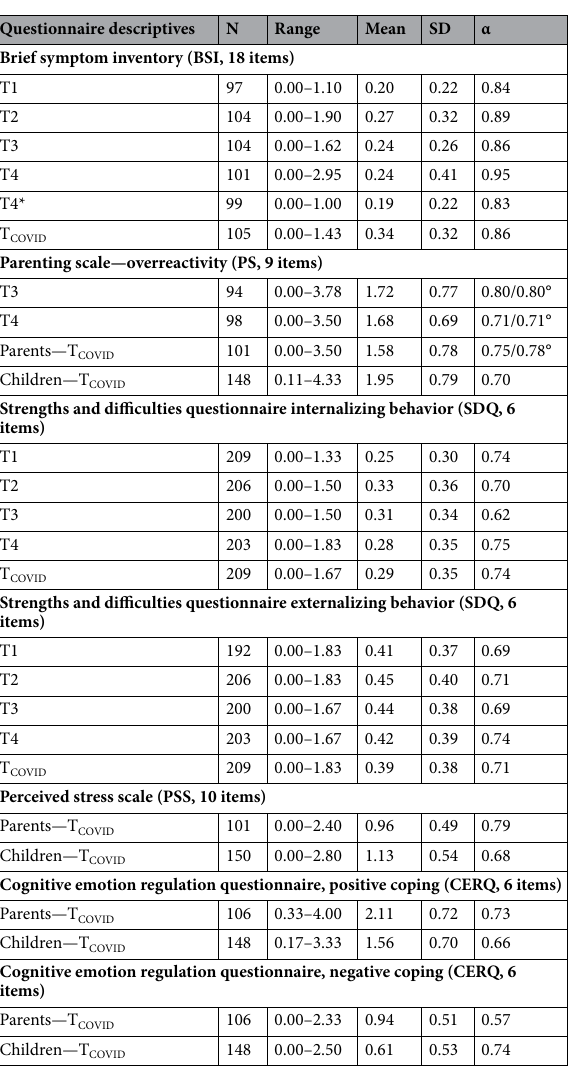
Table 3. Descriptives of questionnaire measures. *Without 2 extremes (mean score 2.40 and 2.95). °Separate alpha’s for questions on child 1 and child